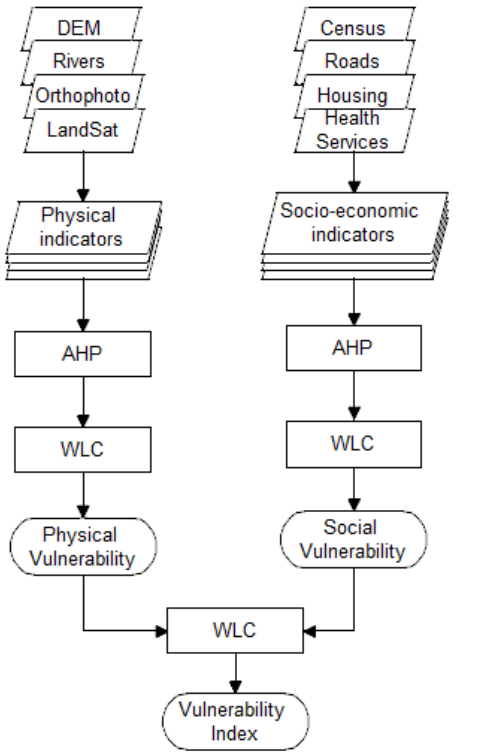
Figure 3. Flowchart of the methodology